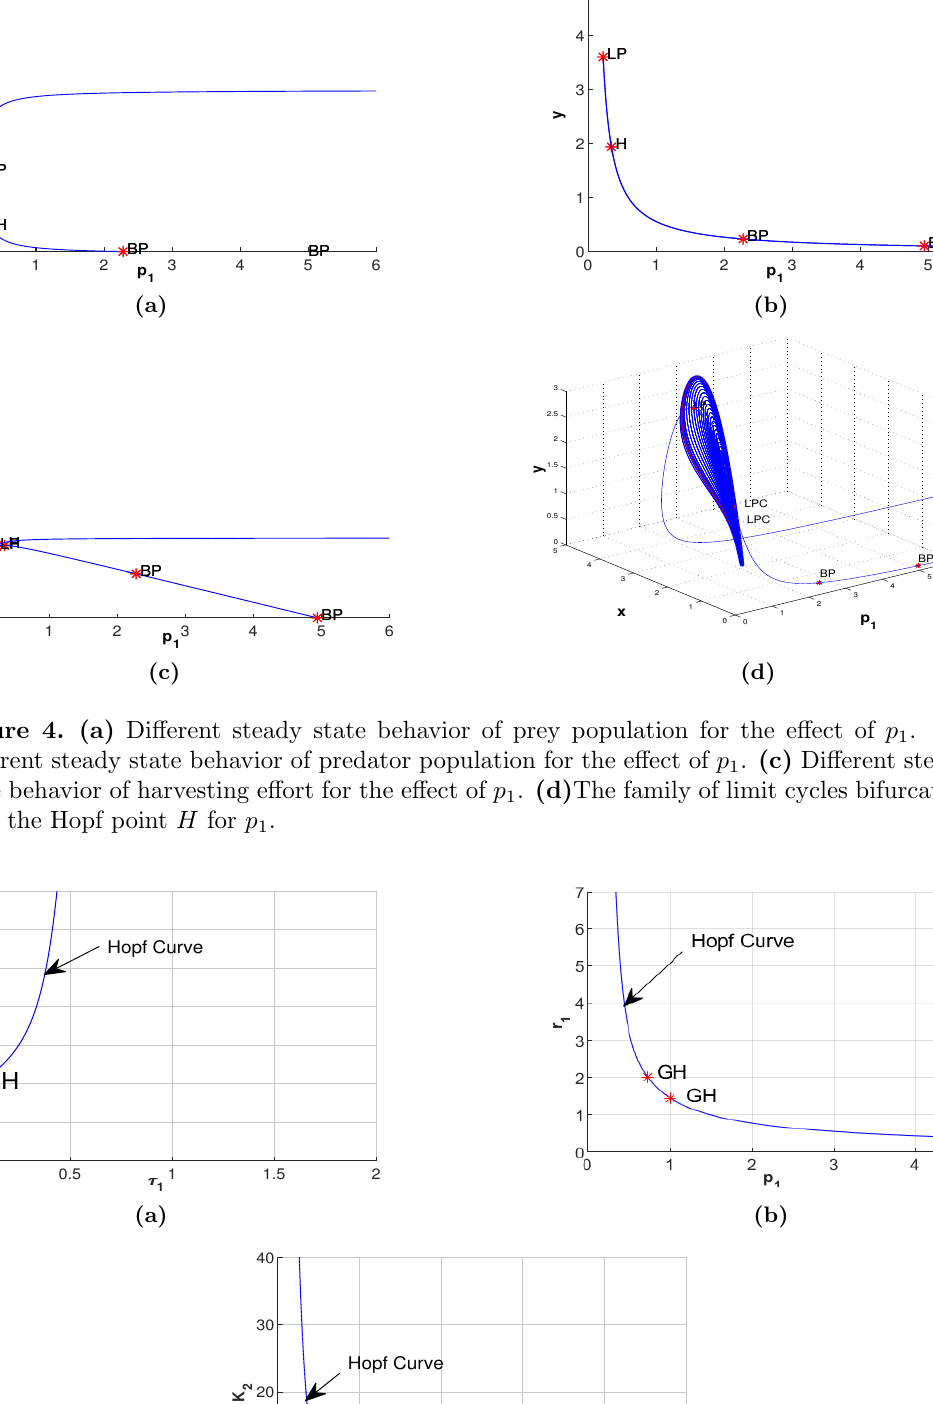
Figure 5. (a) The two parameters bifurcation diagram for τ 1 bifurcation diagram for p 1 its population naturally. We note the following observations by numerical